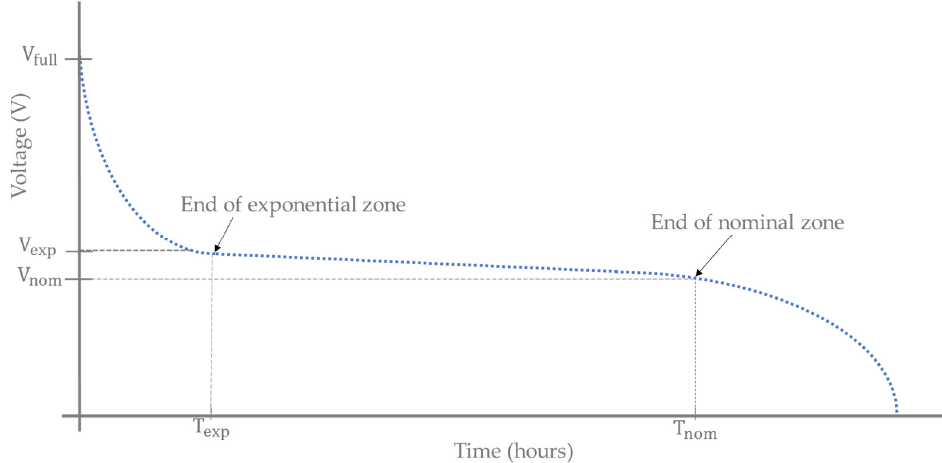
Figure 6. Typical conventional battery discharge curve.